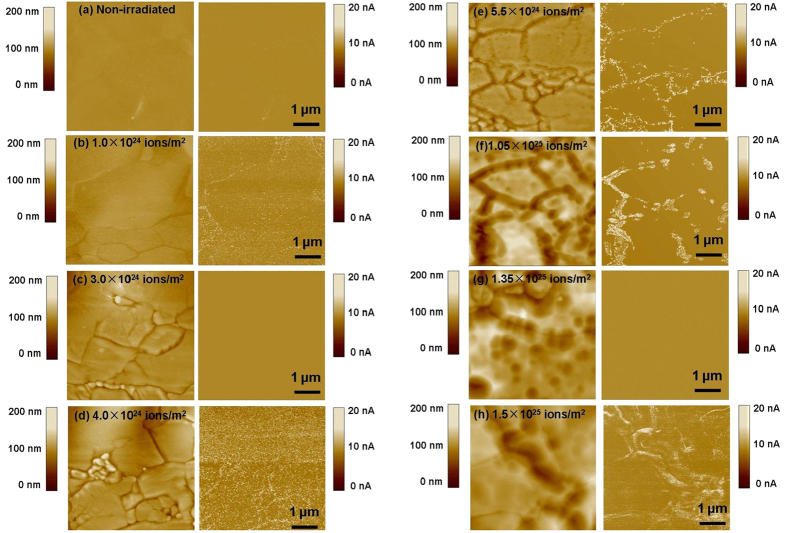
Surface topography (left) and simultaneously measured current images (right) of W crystal prior to H irradiation (a), and irradiated with hydrogen ions at fluences of (b) 1.0 × 1024/m2, (c) 3.0 × 1024/m2, (d) 4.0 × 1024/m2, (e) 5.5 × 1024/m2, (f) 1.35 × 1025/m2, and (g) 1.5 × 1025/m2. CAFM measurements were performed at Vtip = −20 mV (b–g).